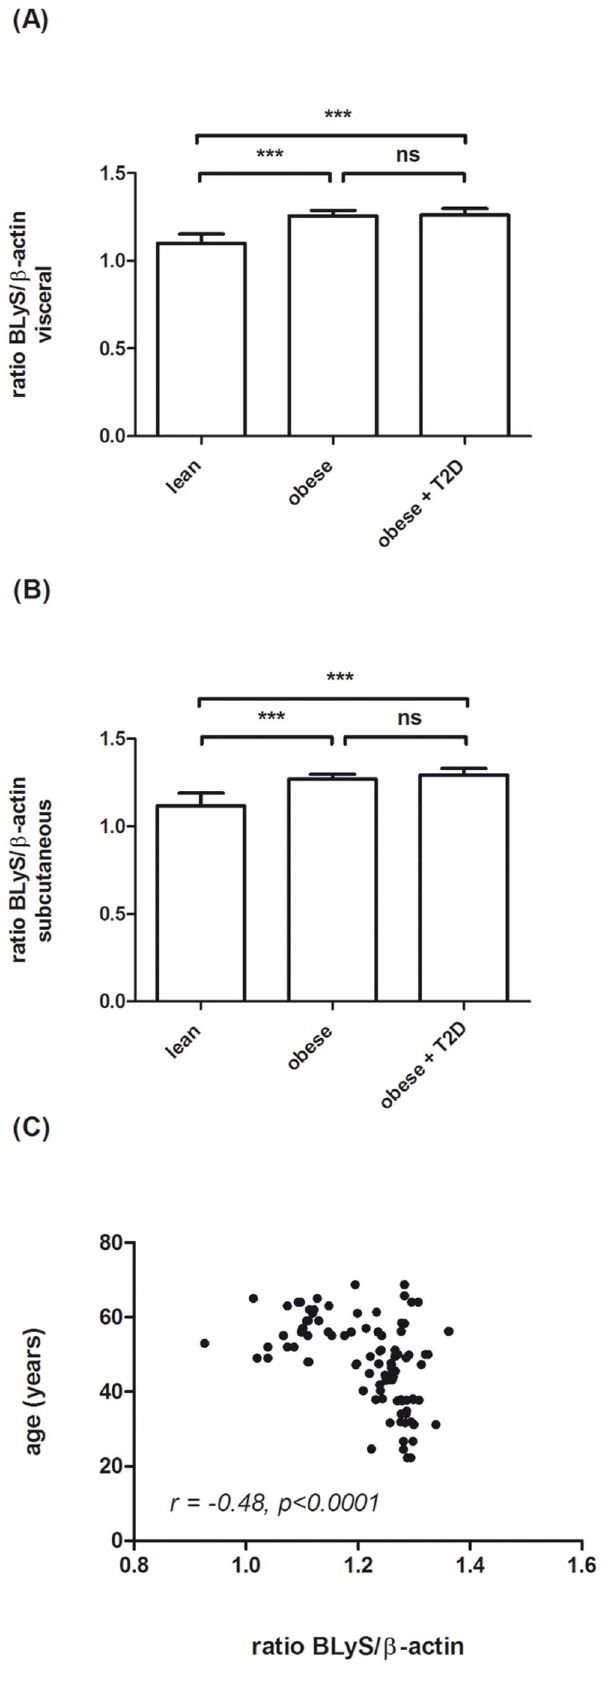
Figure 2. BLyS mRNA level in (A) visceral and (B) subcutaneous adipose tissue of lean control subjects, patients with grade 3 obesity + / 2 type 2 diabetes (T2D). RNA was isolated from total subcutaneous and visceral adipose tissue biopsies. Data in this figure are shown as means + SD. (C) shows a significant negative correlation between age and BLyS expression ( r = 2 0.48, p , 0.0001) in a combined analysis of all biopsy